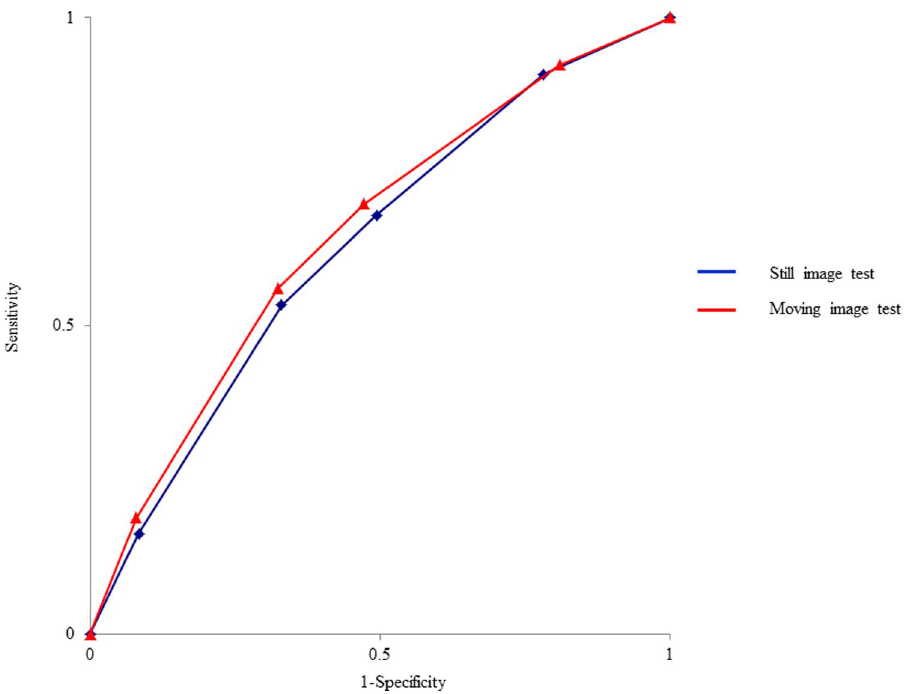
Figure 4. Receiver operating characteristic (ROC) curve of the endoscopic diagnostic grades is according to the certainty of each test correlated with sensitivity and (1 – specificity). The area under the curve (AUC) was as follows: still image test 0.629, moving image test 0.649 ( P =0.303).